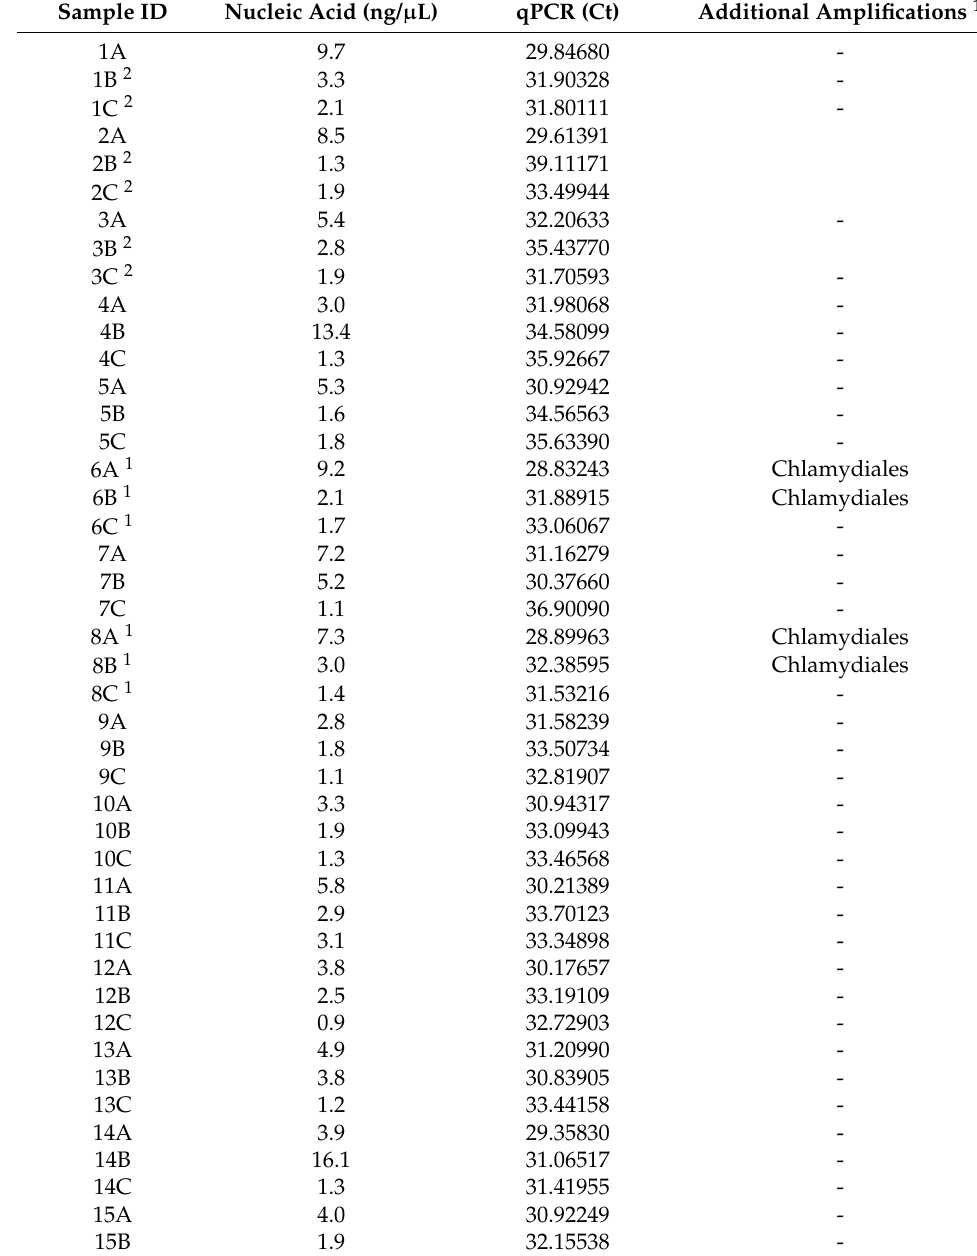
Table 1. Detection of Chlamydial DNA from oropharyngeal, ocular-conjunctival and nasal swabs of 20 loggerhead sea turtles (performed at CIISA). Threshold cycle (Ct) of the quantitative PCR (qPCR) targeting the Chlamydiaceae 23S rRNA gene, and results of the additional amplifications on a sub-set of samples 1